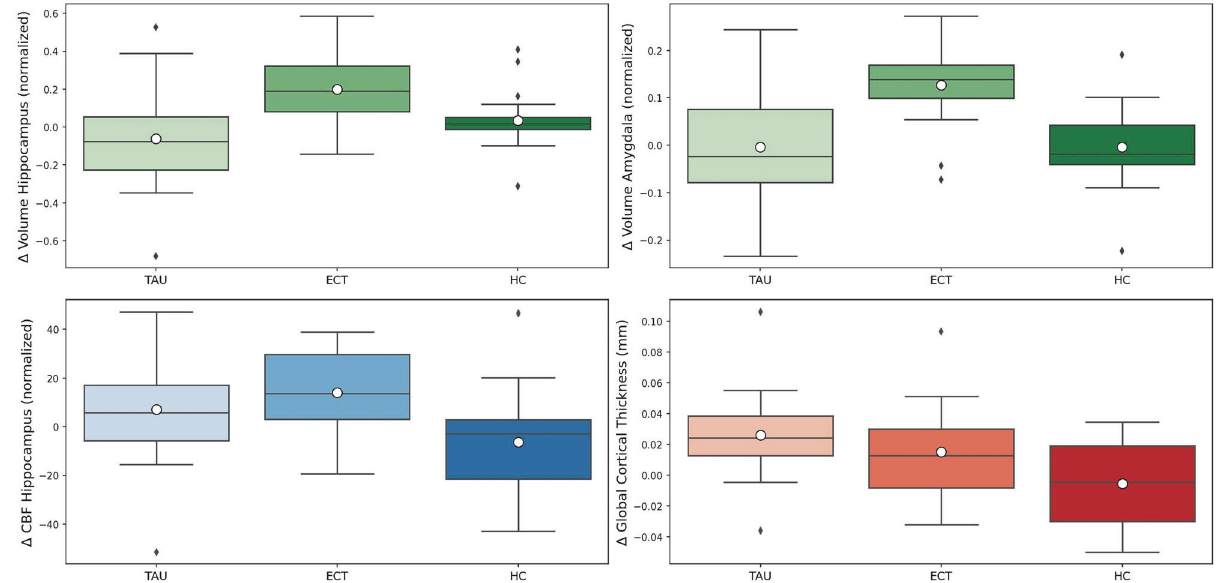
Fig. 2 Group differences between timepoints (follow up – baseline) in subcortical and cortical MRI measurements. CBF cerebral blood fl ow, ECT electroconvulsive therapy group, HC healthy controls group, TAU treatment as usual group